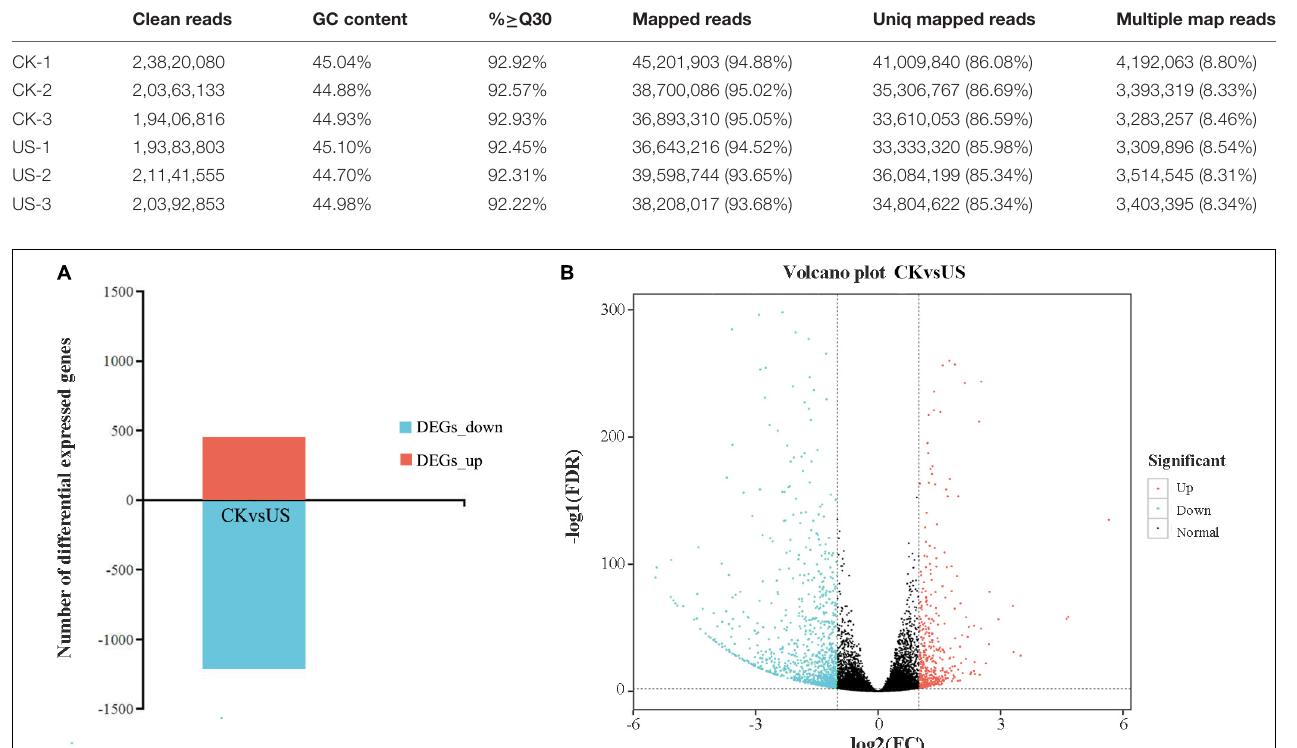
TABLE 1 | Statistics of raw sequencing data results.